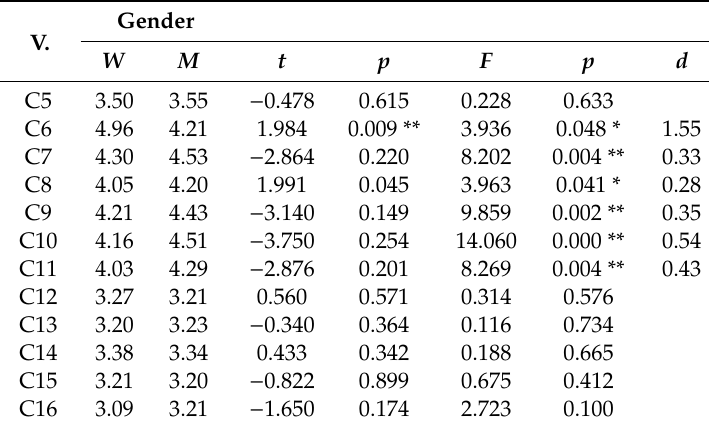
Table 4. T-test and ANOVA test according to